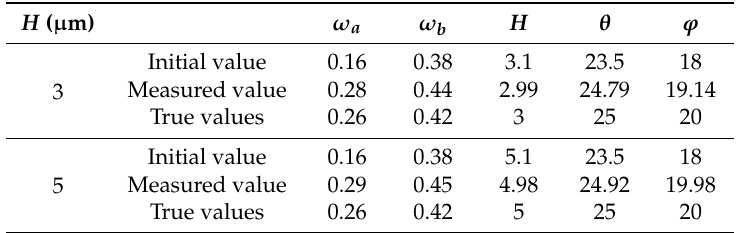
Figure 2. Measured Mueller matrix spectra (blue) and fitted Mueller matrix spectra (red) for the volume gratings whose dielectric constant is a periodic binary distribution, with thicknesses of ( a ) 3 µ m and ( b ) 5 µ m, respectively. Table 1. Simulation results of case 1.